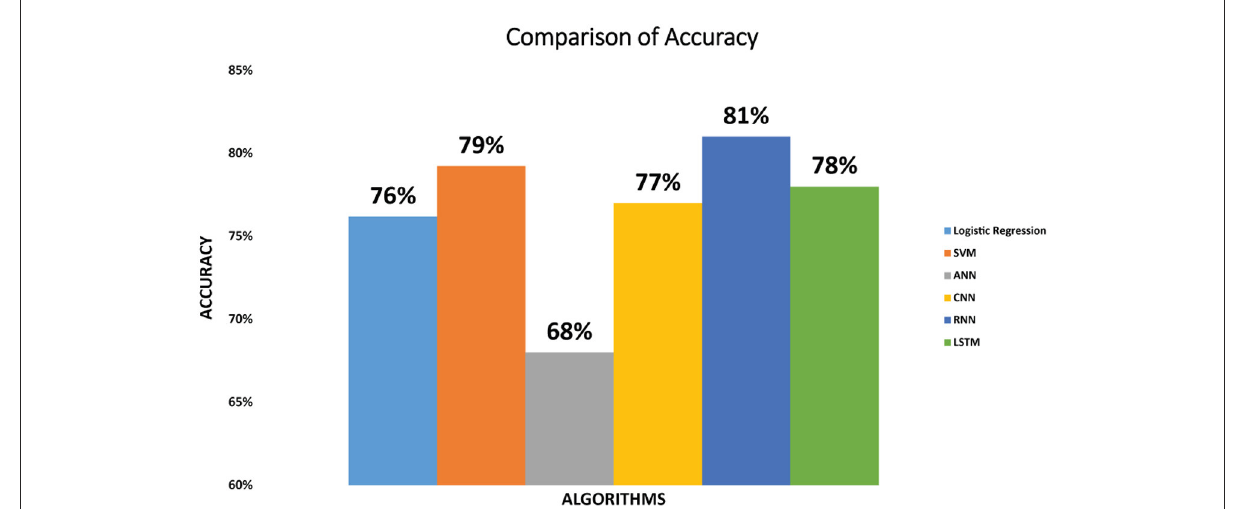
FIGURE2 Comparison of accuracy for logistic regression, SVM, ANN, CNN, RNN, and LSTM.